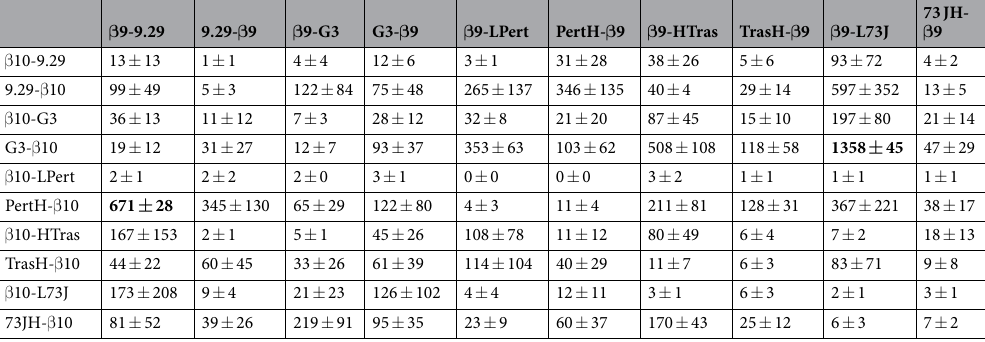
Table 1. Screen of 100 pairs of binders to identify functional TEC pairs. HER2-expressing SKOV3 cells were incubated with clarified lysate of the binders for 1 hr, washed 3 times, and the luminescence measured 30 min after addition of Δ 11S lysate (diluted 1:20) and Nano-Glo substrate (10 μ M). Values are averages of the signal- to-background ratio from screens performed on three separate days ± the standard deviation. The name of the binder indicates the fusion location and orientation, e.g. β 10-LPert is Pertuzumab with β 10 fused to the N-terminus of the light chain, whereas PertH- β 10 is Pertuzumab with β 10 fused at the C-terminus of the heavy chain. Cells with bold text are the top two pairs identified in